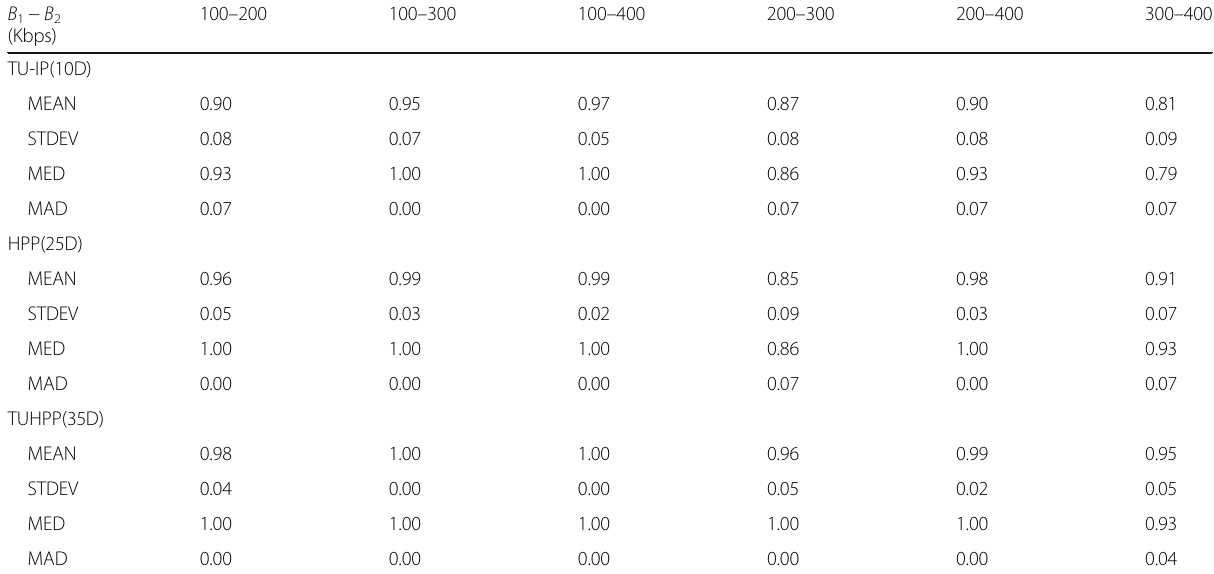
Table 5 Detection accuracy of the double compressed video fragments from its corresponding single compressed ones using TU-IP, HPP feature, and TUHPP feature on CIF video dataset